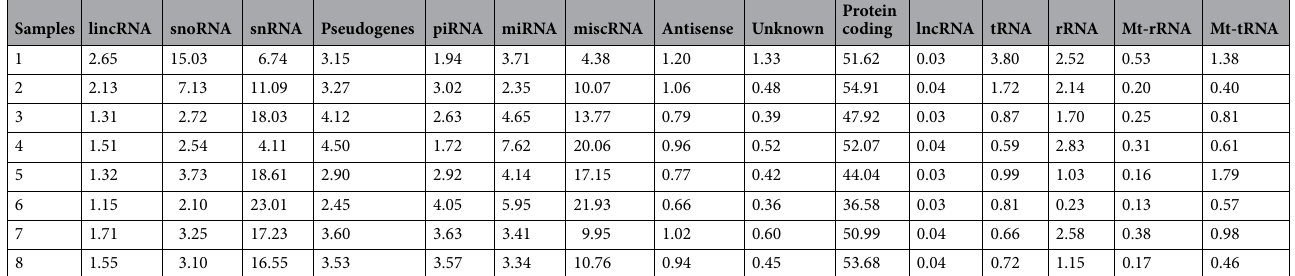
Table 7. Percentage mouse RNA reads mapped to gene biotypes per sample, as annotated in the Mus musculus GRCm38.95, as well as tRNA annotations from UCSC Genome Browser, piRNA annotations from piRNABank.